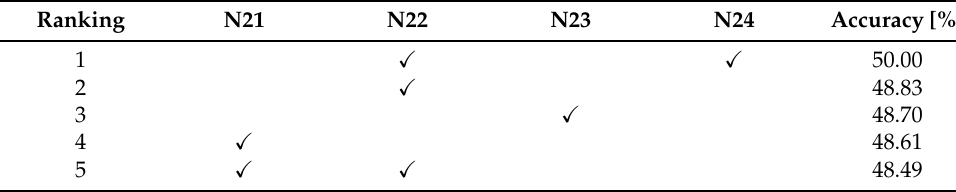
Table 10. Top five recognition accuracies of the added branch nodes.